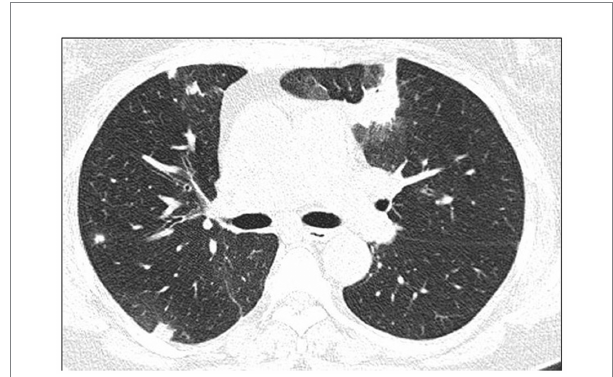
FIGURE 3 High resolution computed tomography scan of a patient with COP. Bilateral nodular